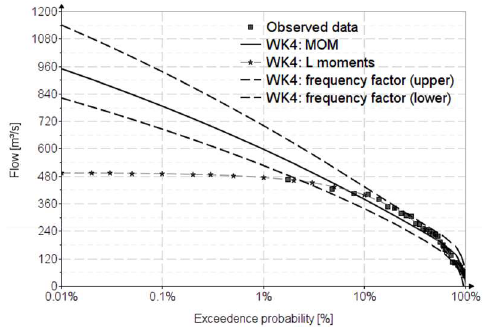
Figure 7. Wakeby distribution.